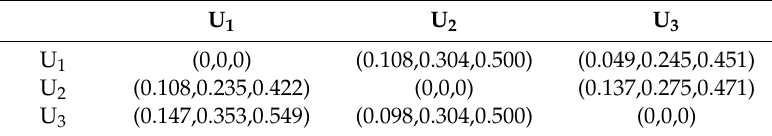
Table 14. The normalized fuzzy direct influence